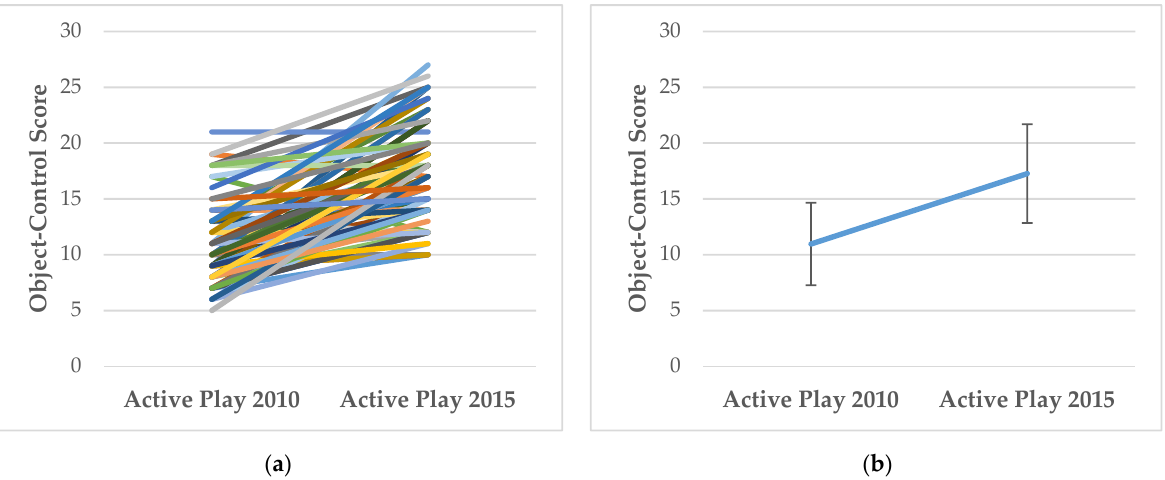
Figure 2. ( a ) Individual changes in object-control scores between Baseline (Active Play 2010) and Follow-Up (Active Play 2015); ( b ) Mean (±SD) changes in object-control scores between Baseline (Active Play 2010) and Follow-Up (Active Play 2015).